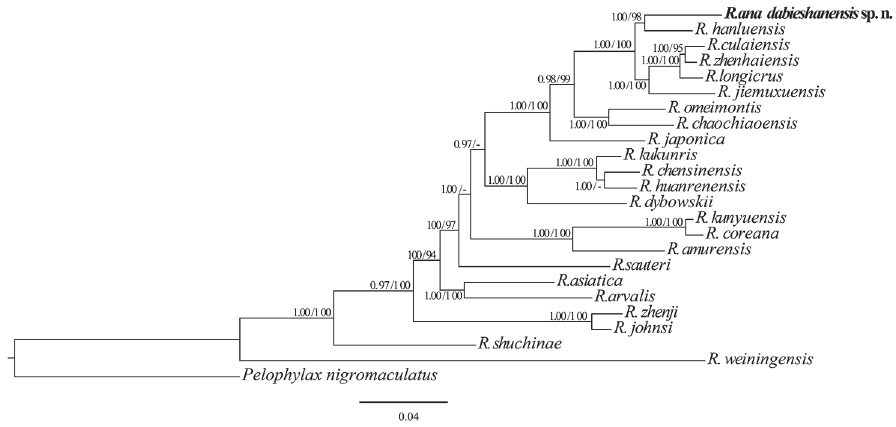
Figure 2. The Bayesian consensus tree resulting from analysis of four mitochondrial genes (12S rRNA, 16S rRNA, ND2 and Cyt b genes) and three nuclear genes (Tyr, RAG1 and BDNF) dataset for Chinese Rana species. The new species is in bold. Number near the nodes are Bayesian posterior probabilities / Maximum Likelihood bootstrap values but only when values are ≥ 0.95 and ≥ 70,